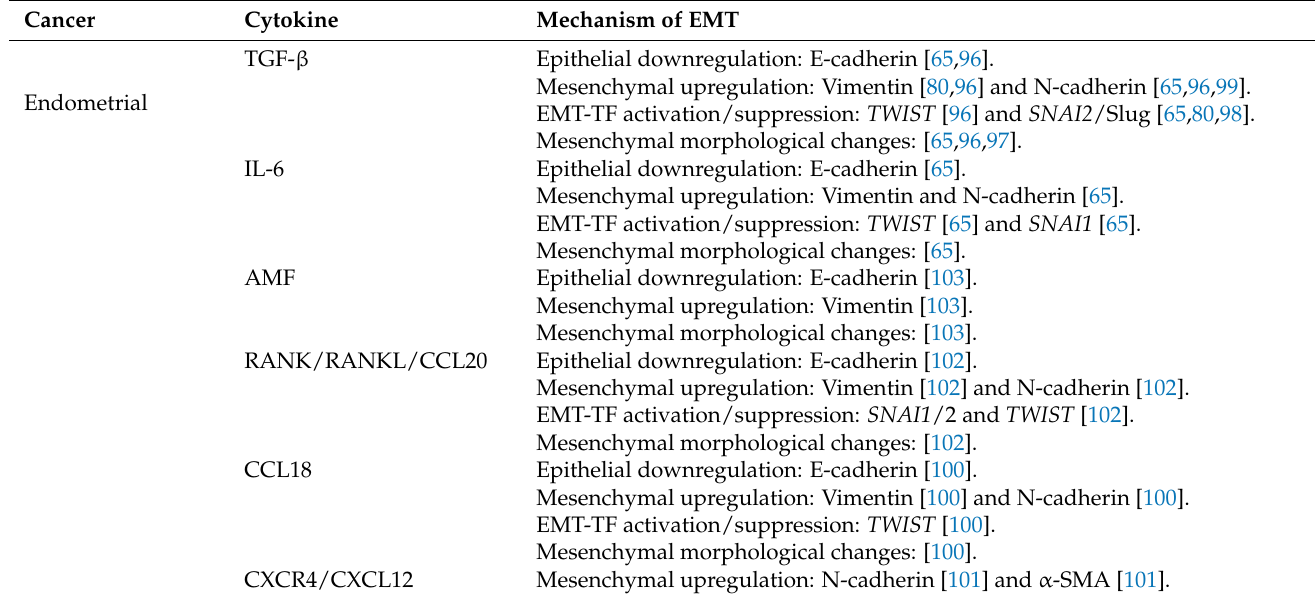
Table 4. EMT changes associated with cytokines/chemokines in endometrial cancer.